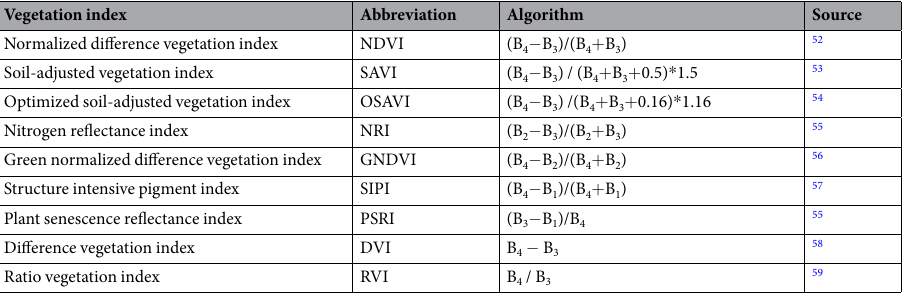
Table 4. Formulas of remote sensing vegetation